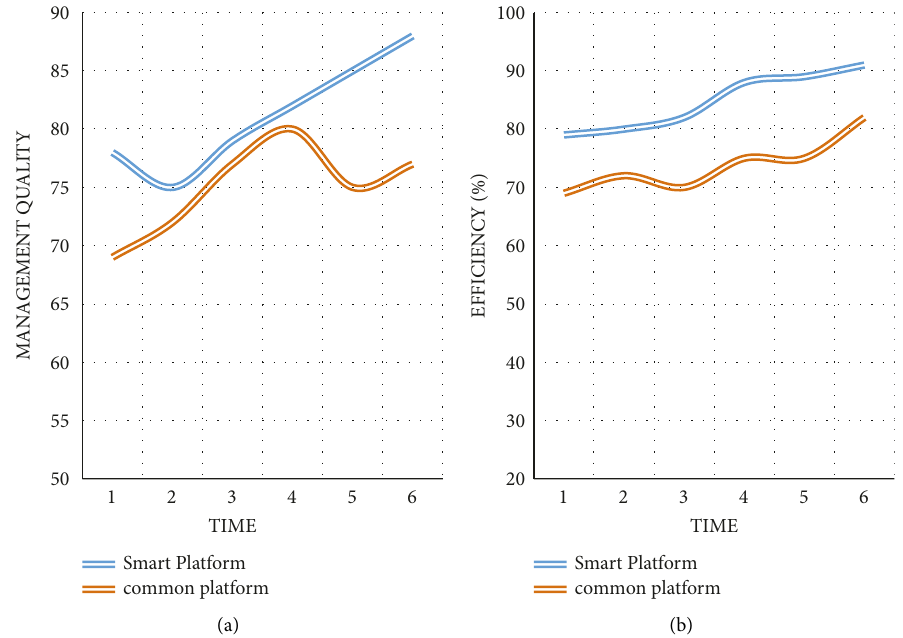
Figure 8: Comparison of platform management quality and efficiency. (a) Platform management quality (b) Platform